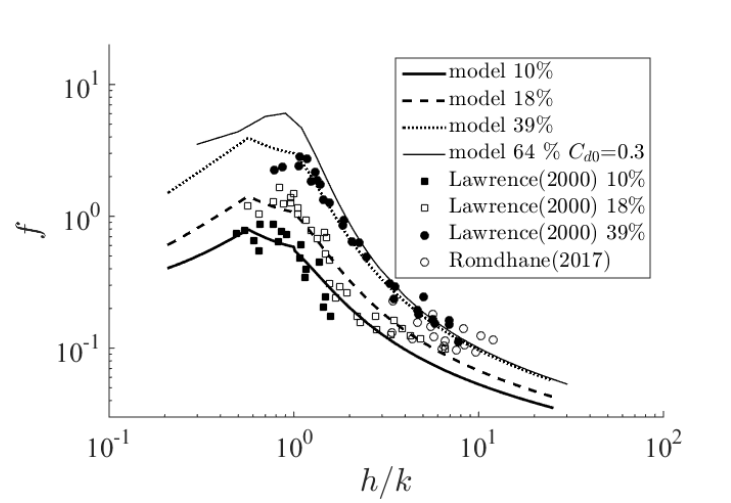
Figure 5. Friction coefficient from [20,24] and those computed with the present model ( R 2 = 0.75, R 2 = 0.89, R 2 = 0.91, R 2 = 0.40).